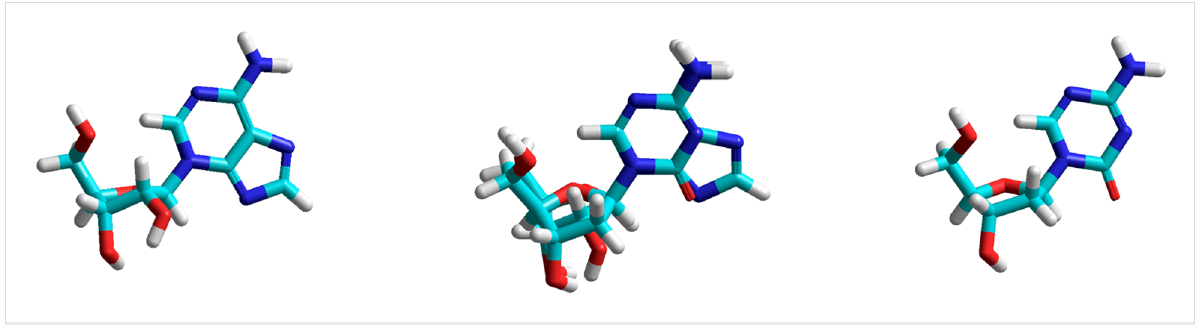
Figure 6: Energy minimized structures of N 3 -( β -D-ribofuranosyl)adenine (left) and 5-aza-2 ′ -deoxycytidine (right) and in the mid both structures are overlapped by the glycosyl bonds (calculations by ab initio, 3-21G level; Polak–Ribiere (conjugate gradient); basis set of parameters; HyperChem 8.1).